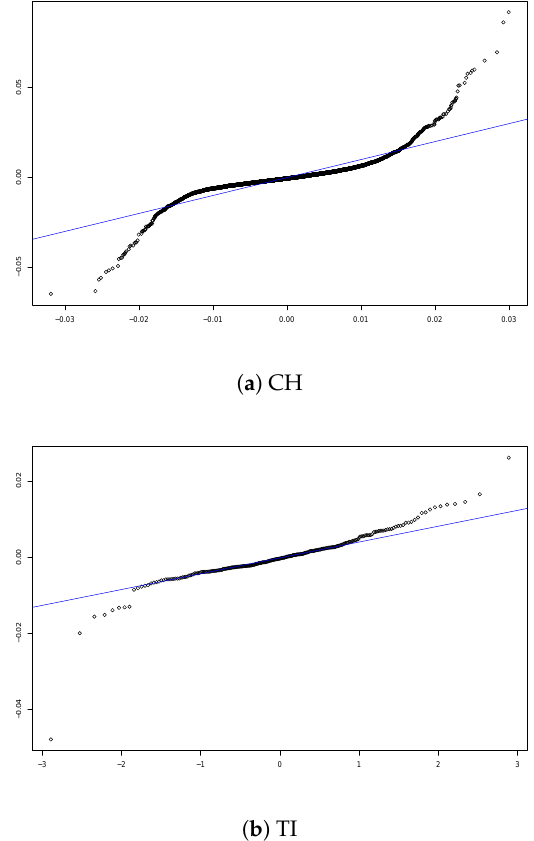
Figure 14. QQ-plot of normally distributed residuals versus theoretical